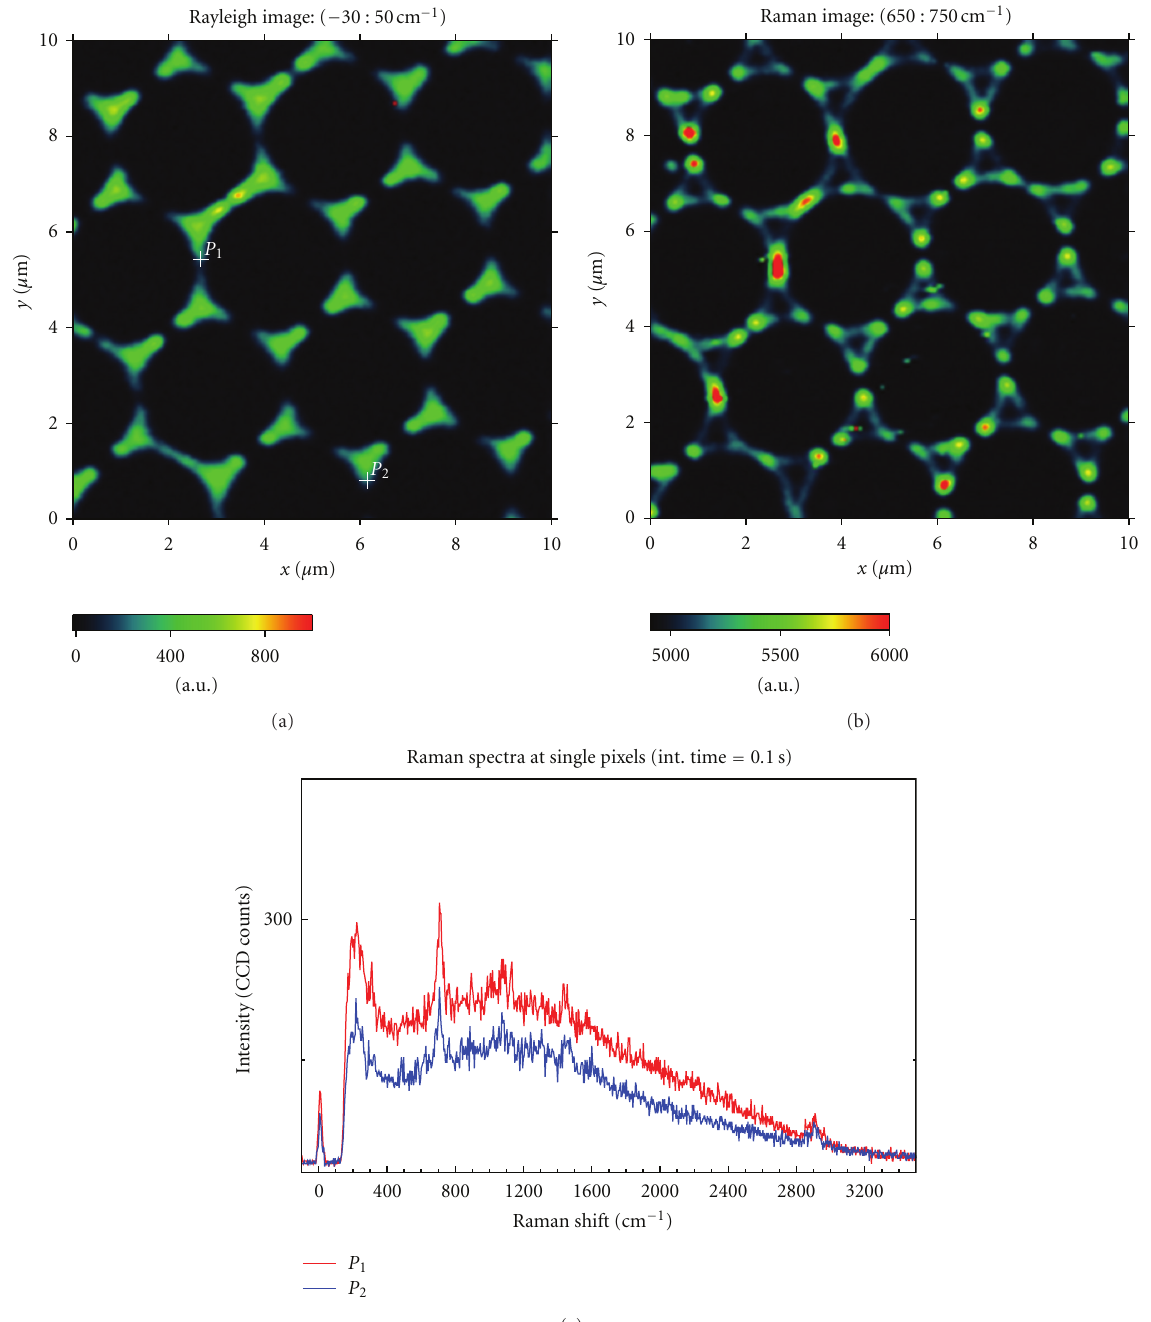
Figure 8: SERS of 1-dodecanethiol molecules. λ = 532nm. P exc = 52 μ W. The spectra below were extracted from the pixels marked.